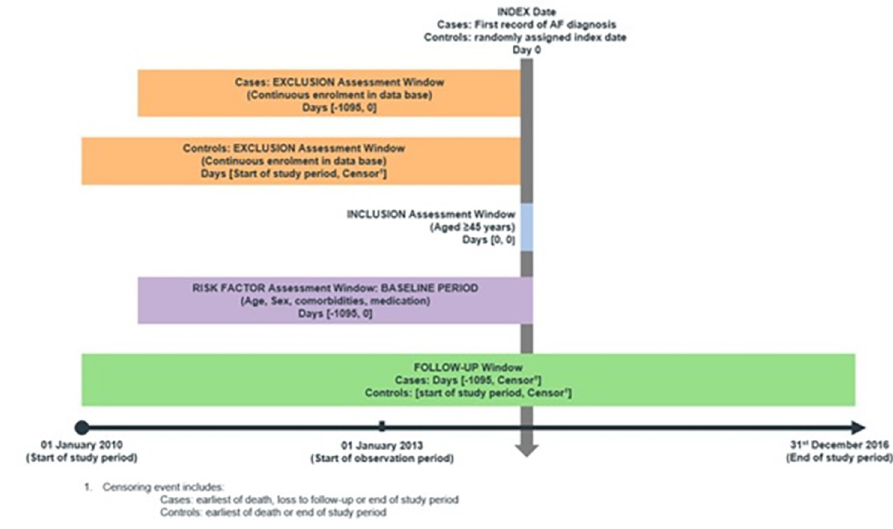
Fig 1. Study design inclusion and exclusion